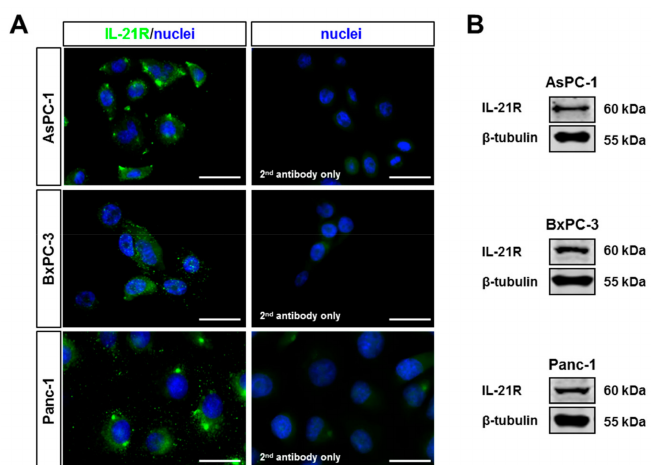
Figure 3. IL-21R expression in human PDAC cell lines. Untreated human PDAC cell lines AsPC-1, BxPC-3, and Panc-1 were tested for IL-21R expression in ( A ) immunofluorescence staining (left: IL-21R + cells, right: Alexa488 goat anti-rabbit IgG only; nuclei: DAPI (blue), IL-21R: Alexa488 (green)) and ( B ) western blot. White bar: 20 µ m.